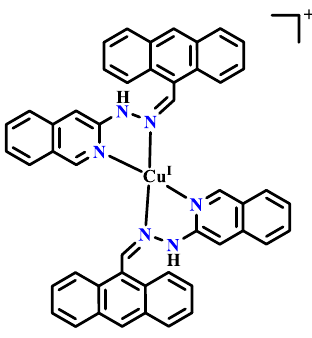
Figure 44. The first copper(I) complex of 9-quinolinylhydrazone showing significant and broad- spectrum anticancer activity in vitro.